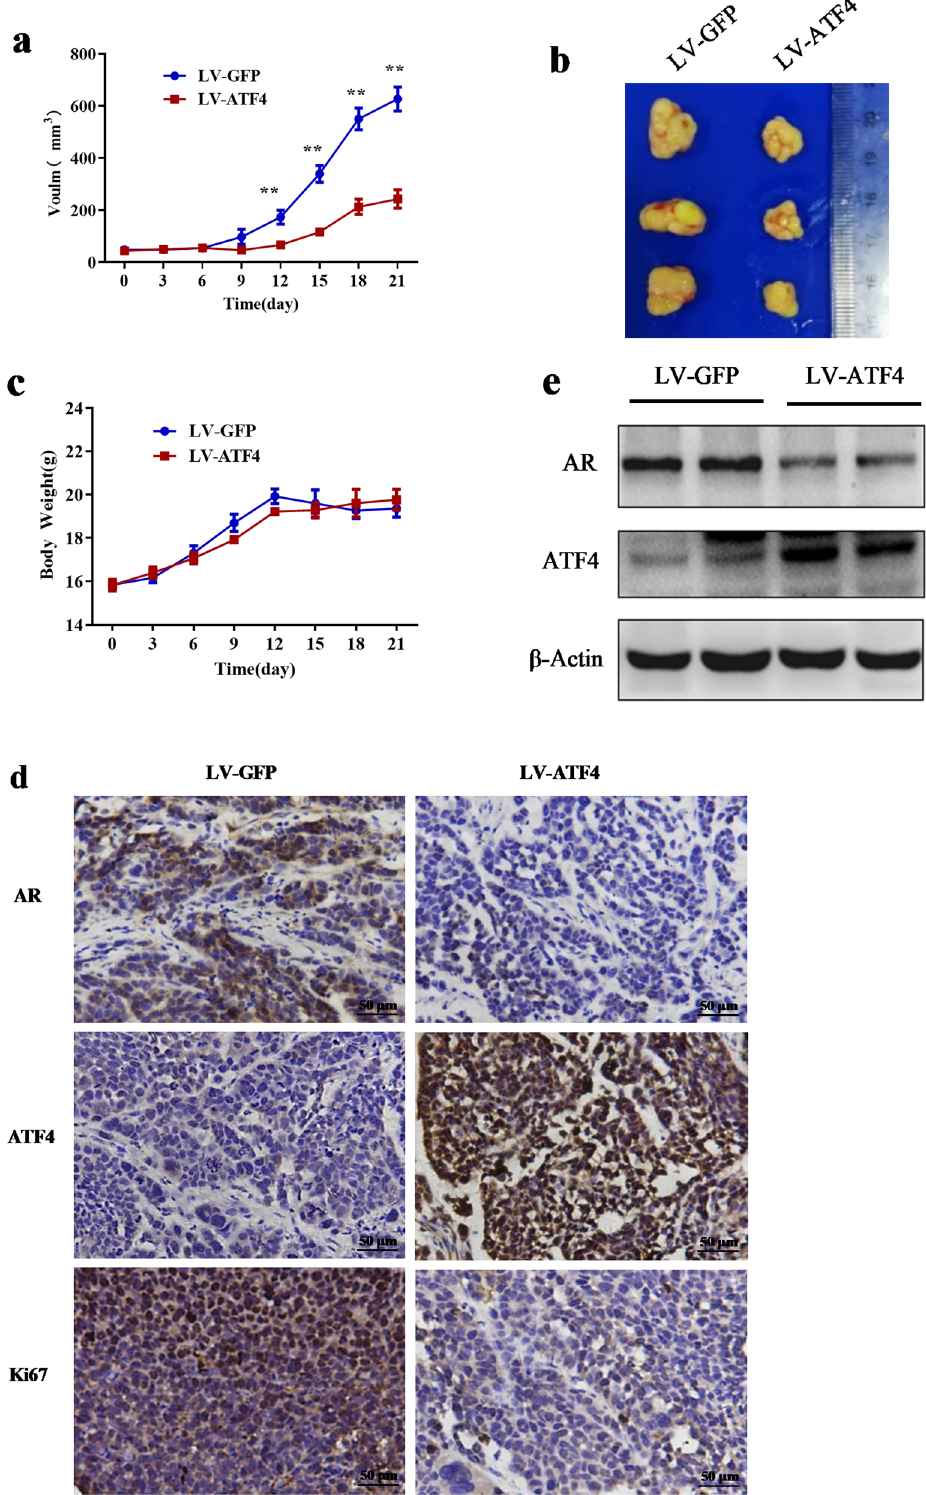
Fig. 8 ATF4 overexpression inhibited tumor growth in a CAL-148 cell orthotopic xenograft mouse model. a Effect of ATF4 overexpression on tumor growth of CAL-148 xenografts. Tumor volume was measured every 3 days and expressed as mean ± SD. Student ’ s t -test, ** p < 0.01 vs . LV-GFP, n = 5. b Representative image of tumors from each group. c Body weight changes in mice during the 21 days ( n = 5). d Representative tumor tissues were sectioned and subjected to immunohistochemistry staining (magni fi cation, ×400). scale bar: 50 μ M. e Representative tumor tissues from each group were prepared and subjected to western blot assay.